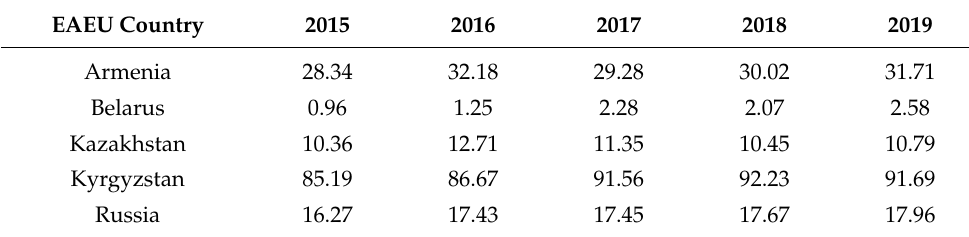
Table 6. Share of renewable energy sources as a percentage (%) of total energy supply *. EAEU